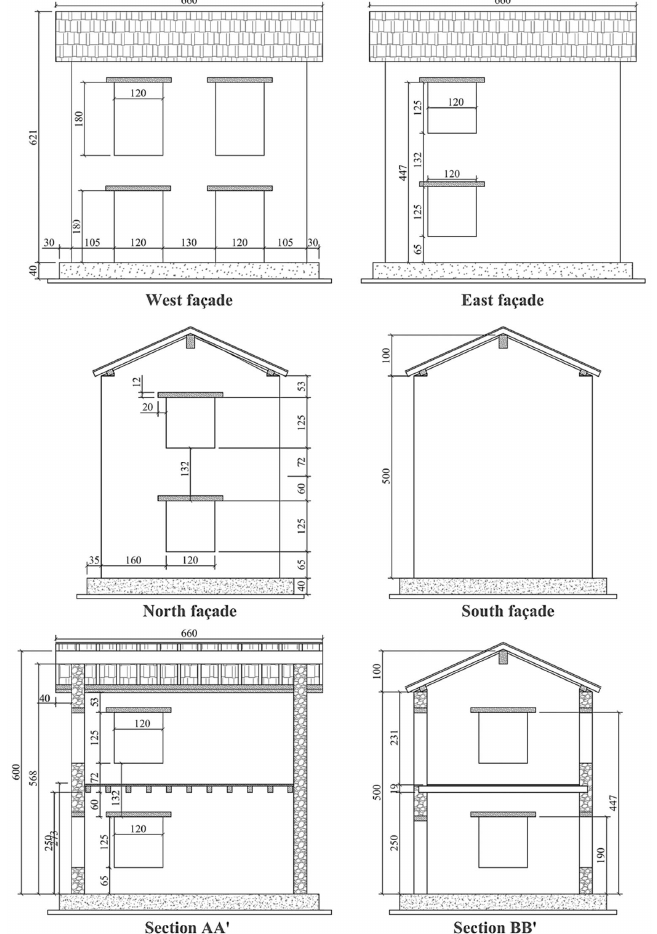
Figure 1. Elevation views and vertical sections of the reference building prototype (Building 1). Units of cm.